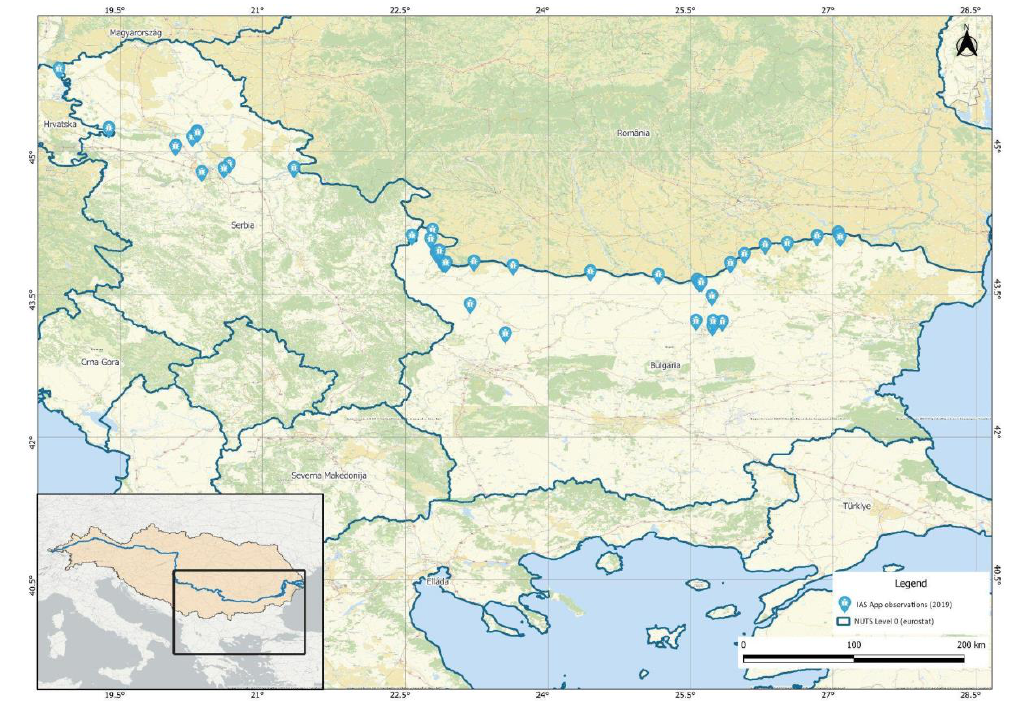
Figure 2. Observations recorded with IASapp in the Lower Danube Region during JDS4 (2019).